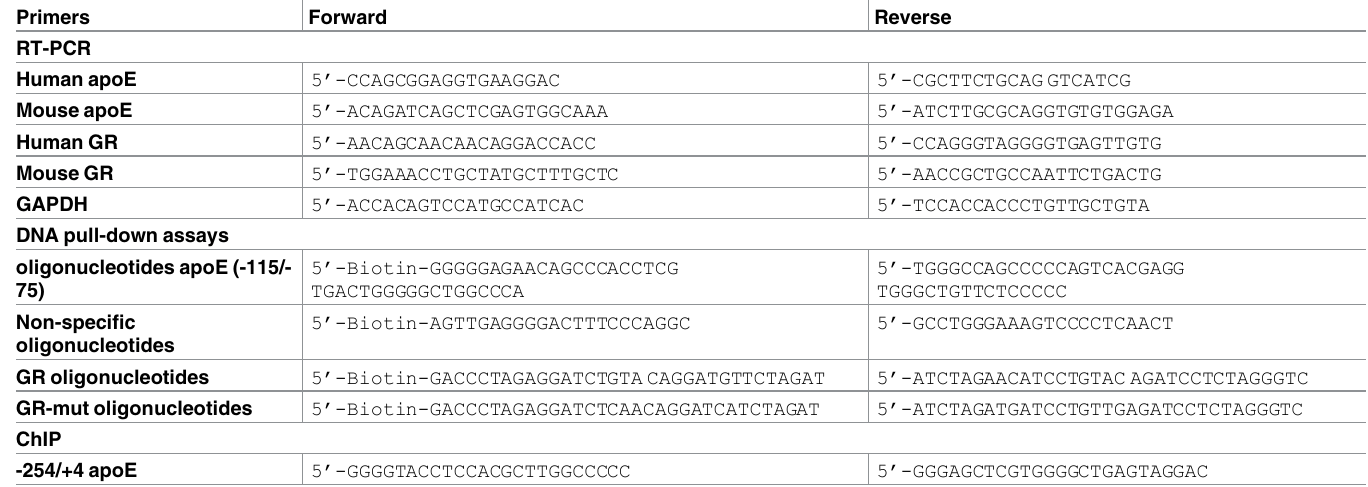
Table 1. The sequences of the primers used for RT-PCR, DNA pull-down assaysand chromatin immunoprecipitation (ChIP) experiments.